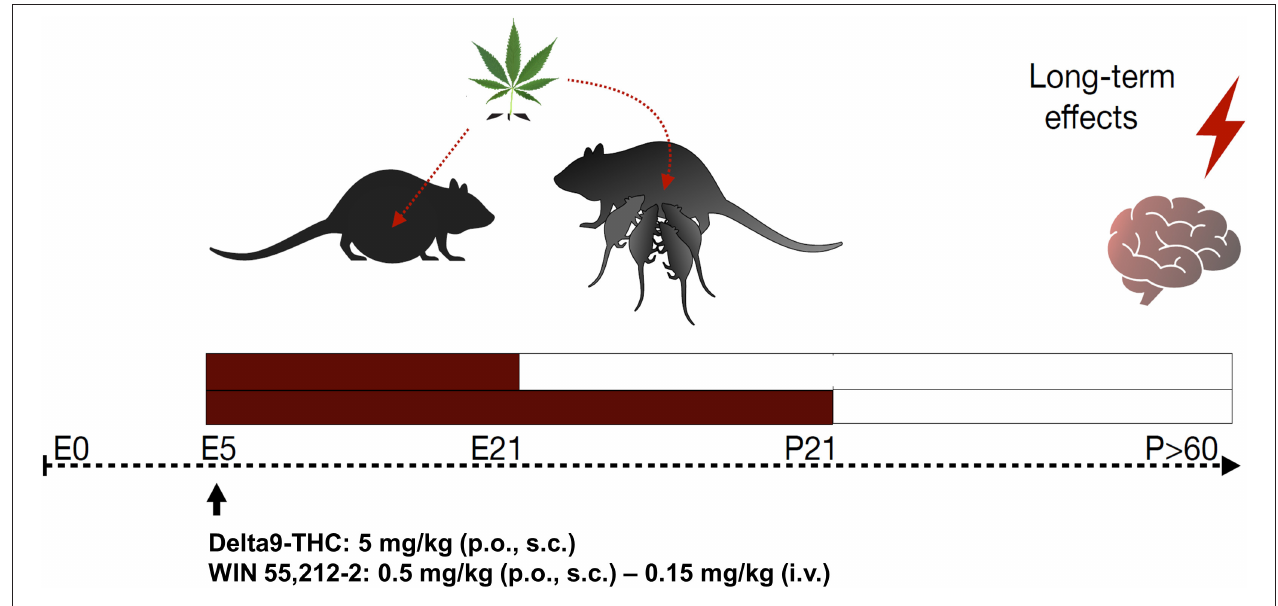
FIGURE 4 | Schematic diagram of perinatal cannabis exposure animal models and long-term behavioral and neurobiological evaluation. E, embrionary; P, postnatal; 1 9THC, delta-9-tetrahydrocannabinol; p.o., per os; s.c., subcutaneous; i.v.,